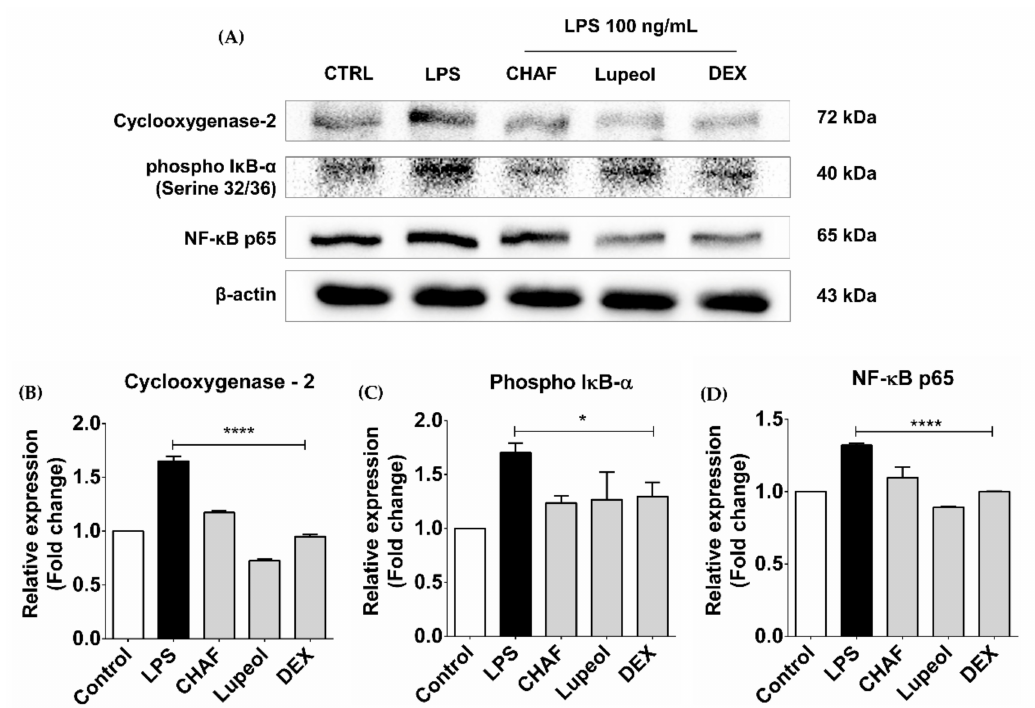
Figure 6. Expression of COX-2, phospho I κ B- α and NF- κ B p65 proteins in LPS-stimulated THP-1-derived macrophages. THP-1 cells were differentiated to macrophages using PMA, then the cells were pre-treated with CHAF (2.5 µ g/mL) and lupeol (25 µ g/mL) for 30 min, followed by treatment with LPS (100 ng/mL) for 1 h. Specific antibodies against phospho I κ B- α , NF- κ B p65 and COX-2 ( A ) were used to detect protein expression. Beta actin was used as the internal control. A densitometry scanner was used to quantify the level of protein normalized to internal control and the relative expression of phospho I κ B- α ( B ), NF- κ B p65 ( C ) and COX-2 ( D ) are shown. Data are presented as mean ± SD. * p < 0.05; ** p < 0.01; *** p < 0.001; **** p < 0.0001 compared to LPS treatment. LPS: Lipopolysaccharide-stimulated macrophages; Dex: Dexamethasone; CHAF: subfraction no.